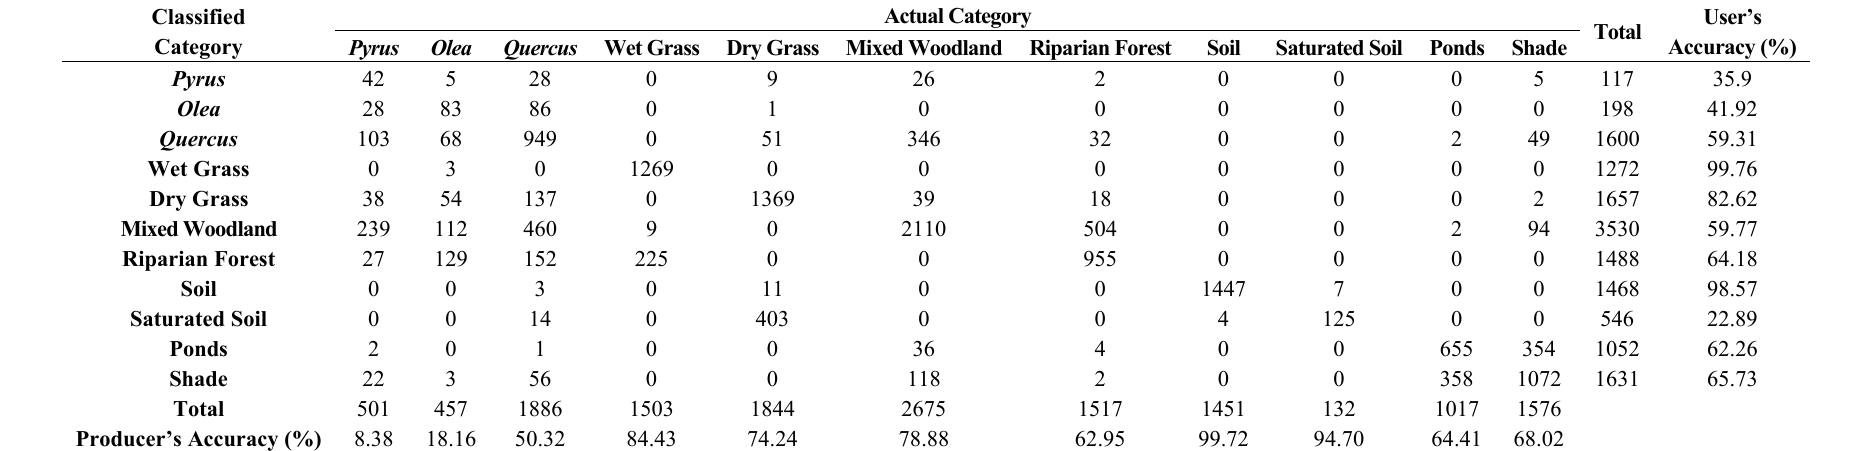
Table 8. Error matrix of the QuickBird fused image from May 2009 at 60 cm and classified by the SVM